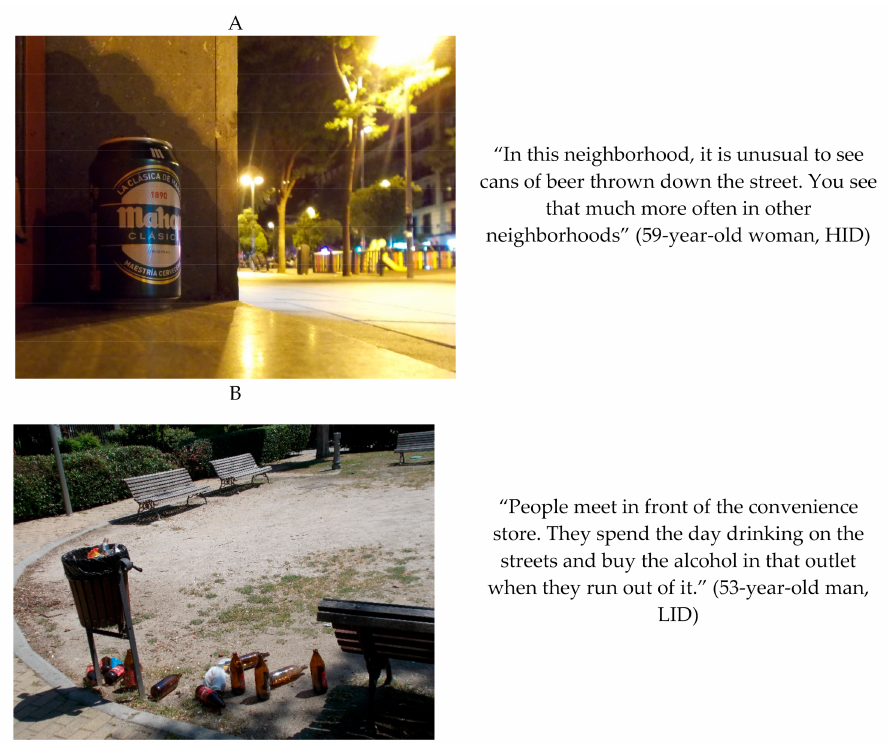
Figure 6. ( A ) Signs of alcohol consumption perceived in high-income level neighborhood. Photograph: “The loner can”. ( B ) Signs of alcohol consumption perceived in low-income level neighborhood. Photograph: “More bins are missing in the streets!” Examples of the signs of alcohol consumption results obtained in the high-income district (HID, Chamber í ) ( A ) and in the low-income district (LID, Villaverde) ( B ) through Photovoice.